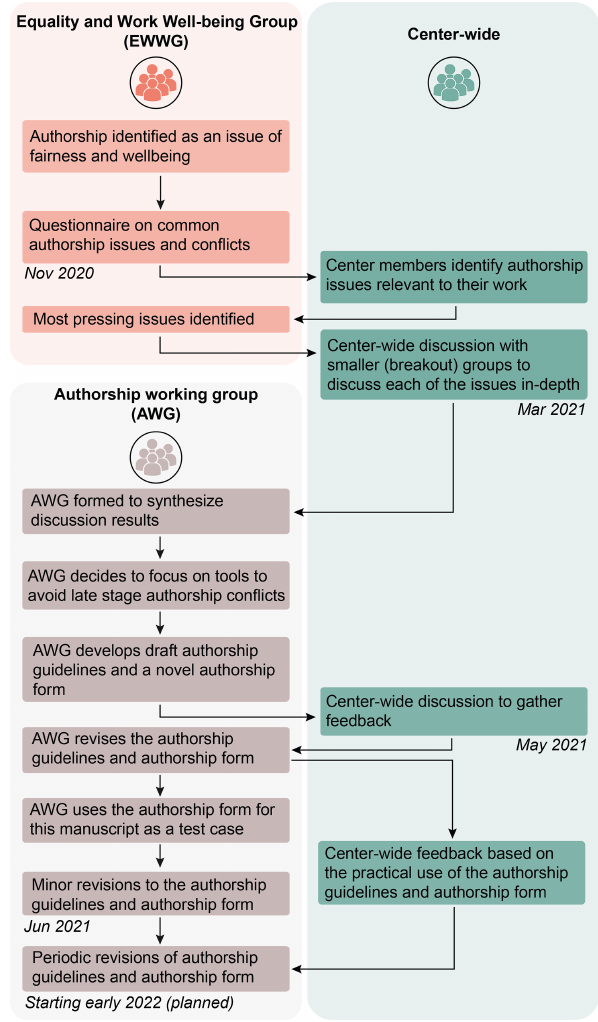
Figure 1. Flowchart describing the actors and actions leading up to the authorship form and